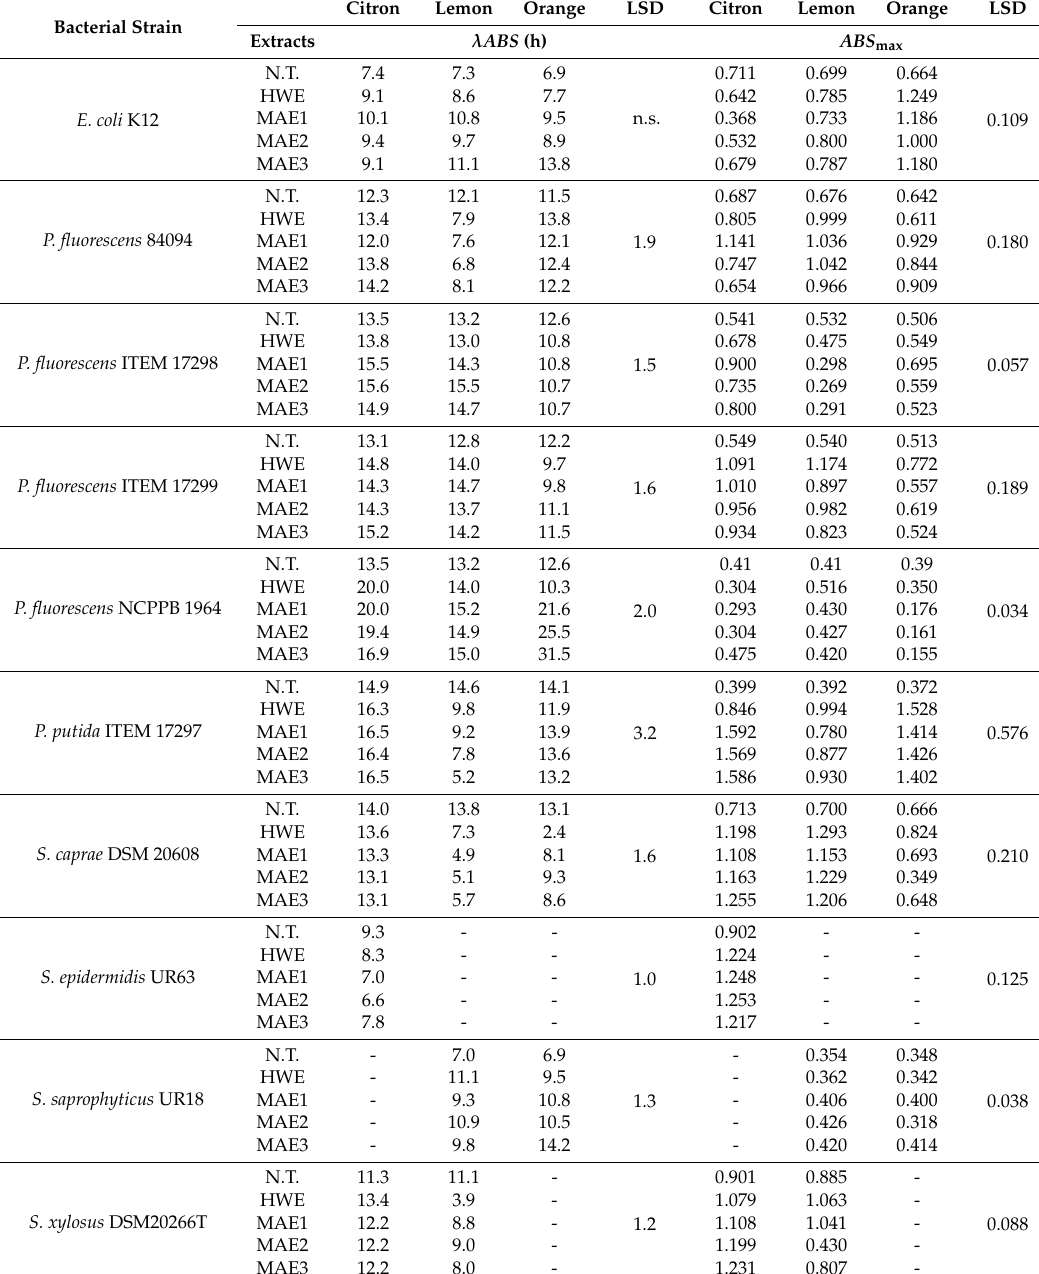
Table 2. Lag phase ( λ ABS ) and maximum optical density ( ABS max ) shown by bacterial cultures amended with different aqueous extracts of citron, lemon, and orange peels. Citron Lemon Orange LSD Citron Lemon Orange LSD Bacterial Strain Extracts λ ABS